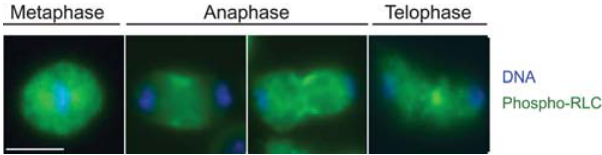
Figure 1. Myosin II RLC is phosphorylated in the cleavage furrow of dividing Drosophila cells. Immunofluorescent localization of D NA (blue), and phospho-RLC (green) in S2 cells. The scale bar=5 m m.